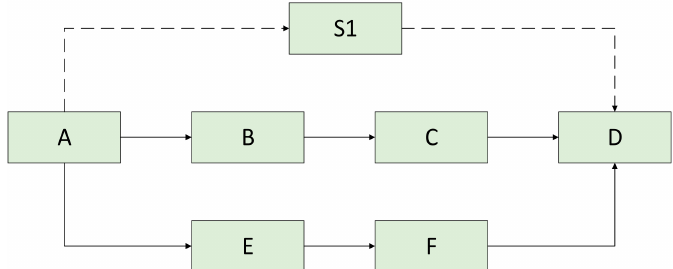
Figure 12. Service chain generation based on geospatial service